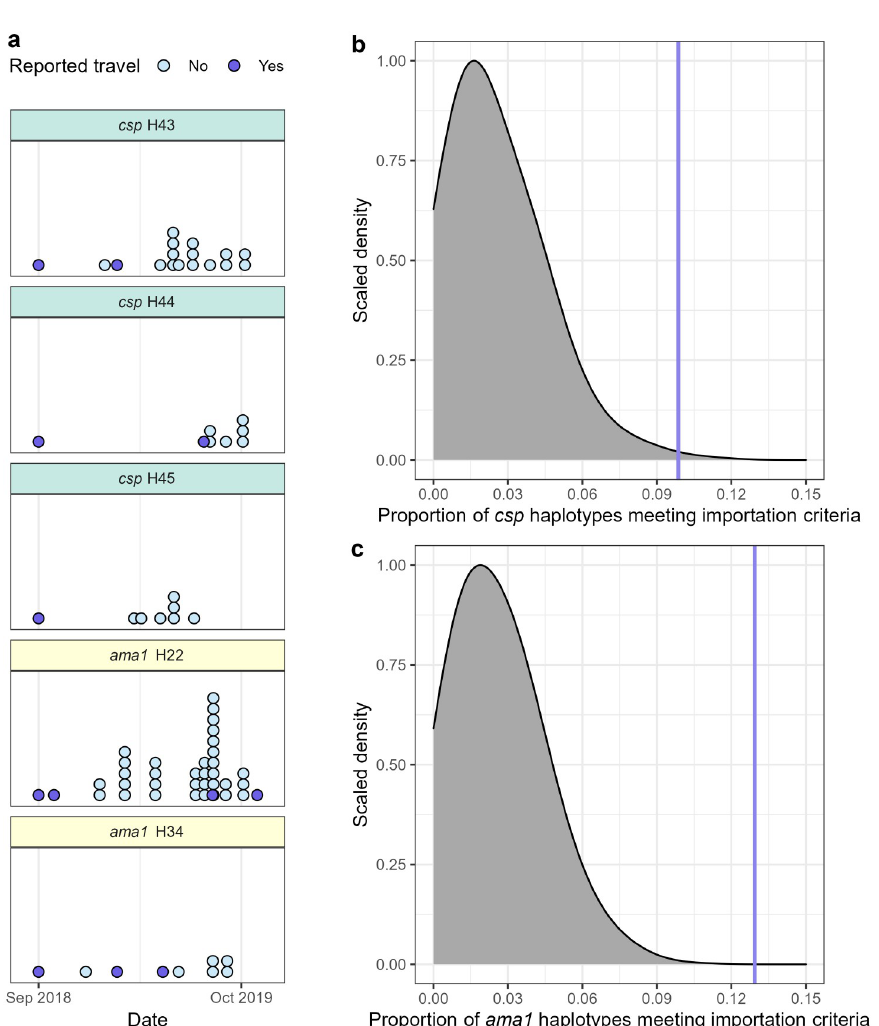
Fig 4. Evidence for haplotype importation into Central Turkana by individuals reporting travel. (a) Gray distribution indicates the expected null distribution of csp haplotypes meeting the candidate importation criteria, and vertical purple line the observed proportion. The proportion of csp haplotypes potentially imported by individuals reporting travel (9.86%) was enriched relative to the permuted null distribution (p = 0.002). (b) Gray distribution indicates the expected null distribution of ama1 haplotypes meeting the candidate importation criteria, and vertical purple line the observed proportion. The proportion of ama1 haplotypes potentially imported by individuals reporting travel (12.9%) was also enriched relative to the permuted null distribution (p < 0.001). (c) 5 representative candidate imported haplotypes, all of which were potentially imported by one index case at the St. Patrick health facility who reported travel to western Turkana. Each dot represents one infection with the specified